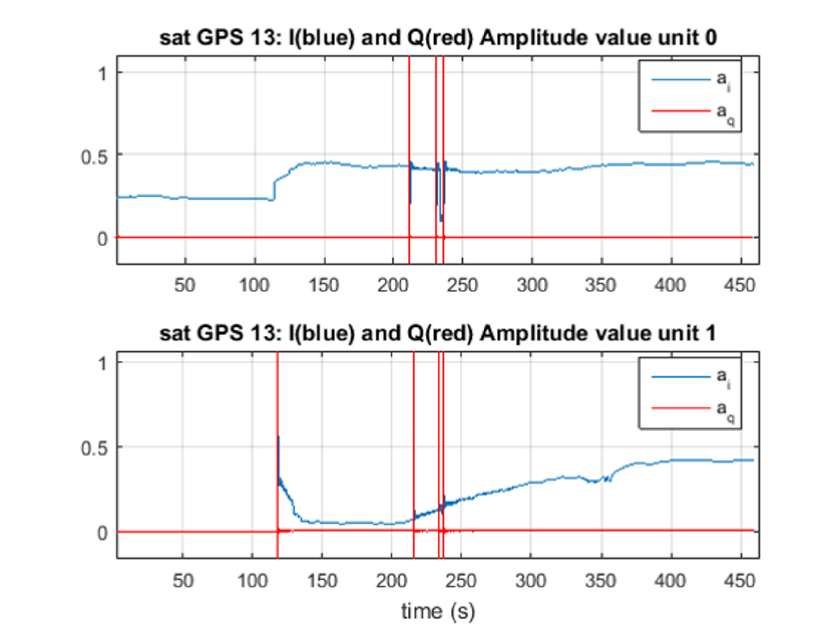
Figure 15. Amplitude estimation for satellite 13, using TEXBAT ds7. In blue, the in-phase amplitude estimation, and in red, the quadrature estimation are shown.